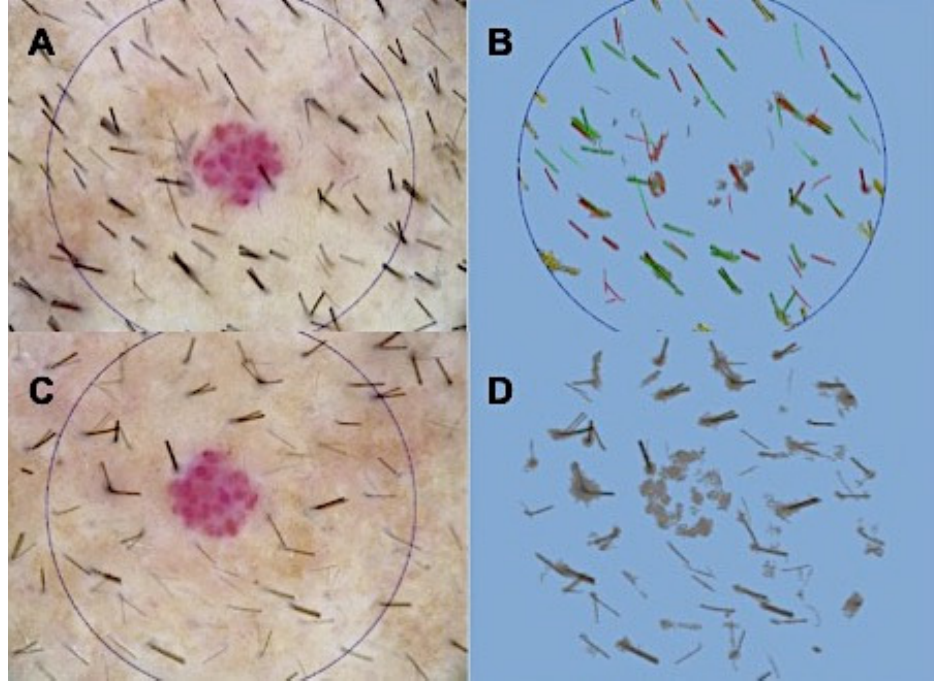
Figure 1. Trichoscan digital image analysis performed by Fotofinder in a patient shown in Figure 2. ( A , B ) At T5 post-operative hair count was 87.5 hairs / 0.65 cm 2 , and proportions of telogen and anagen hairs were 50.6% and 47.5%, respectively. ( C , D ) At T0 pre-operative hair count was 69.2 hairs / 0.65 cm 2 , and proportions of telogen and anagen hairs were 39.4% and 57.0%, respectively.